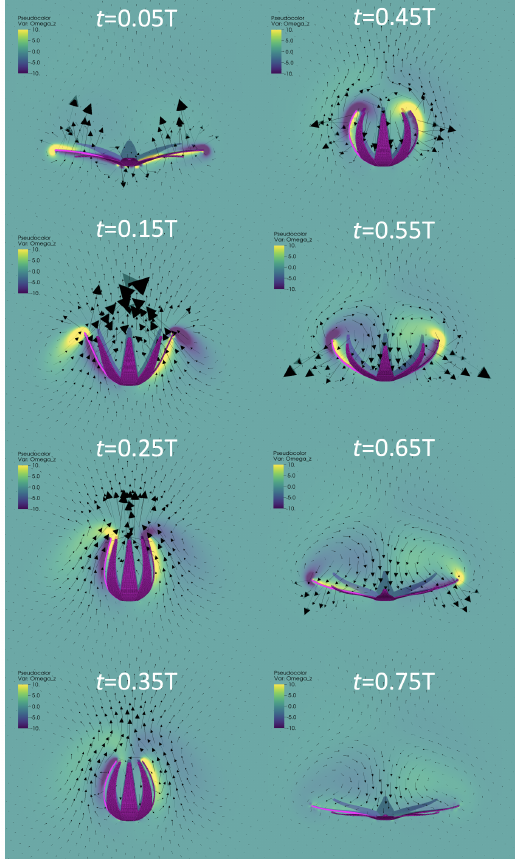
Fig. 6: The z -component of vorticity and the velocity vector field taken on a 2D plane through the central axis of the coral at Re f = 10 . This Re f corresponds to a typical coral polyp.The colormap shows the value of ω z , the arrows point in the direction of flow, and the length of the vectors correspond to the magnitude of the flow. Snapshots are taken during the fourth pulse at times that are 5%, 15%, 25%, 35%, 45%, 55%, 65%, and 75% through the